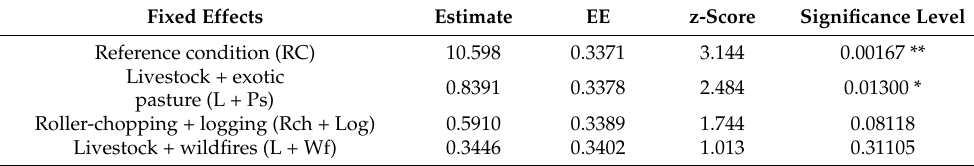
Table 3. Results of generalized linear model (number of seeds per sample-types of forests, data = seeds, link = log, init. Theta = 0.5899), AIC = 1054.2. Fixed effects: forests with different land-management types. Overgrazed + fire + abandonment forest (L + WF + A) does not appear because it is included in the